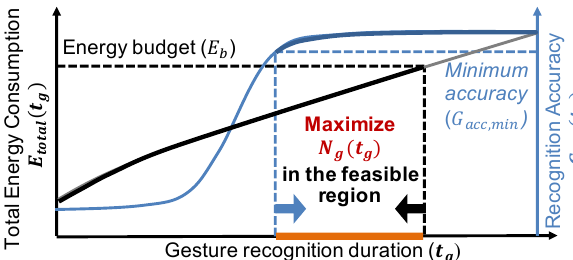
Figure 3. Energy budget and minimum accuracy requirements constrain the gesture recognition duration t g from above and below, respectively. Hence, we maximize the number of recognized gestures within the feasible